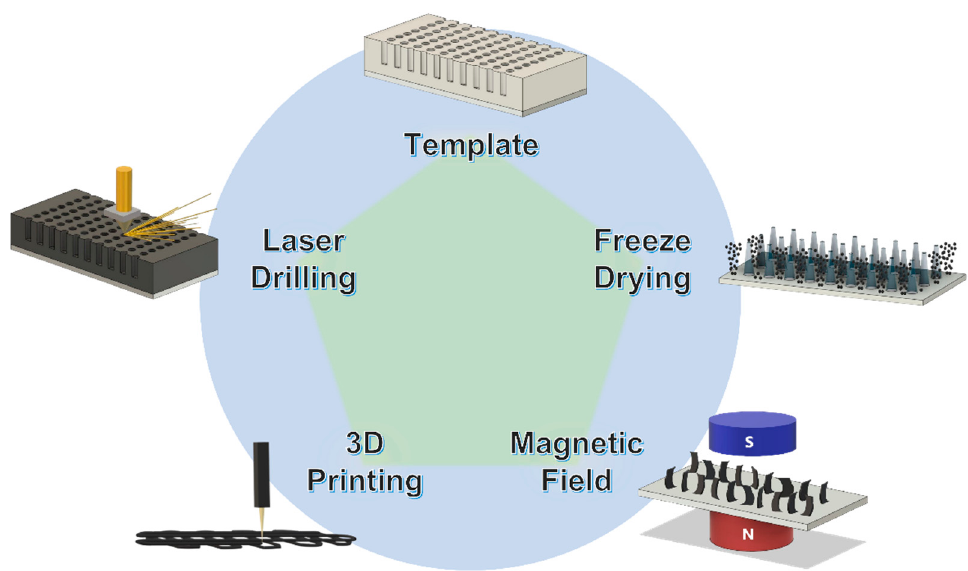
Figure 15. The mainstream processes of low-tortuous electrode manufacturing.